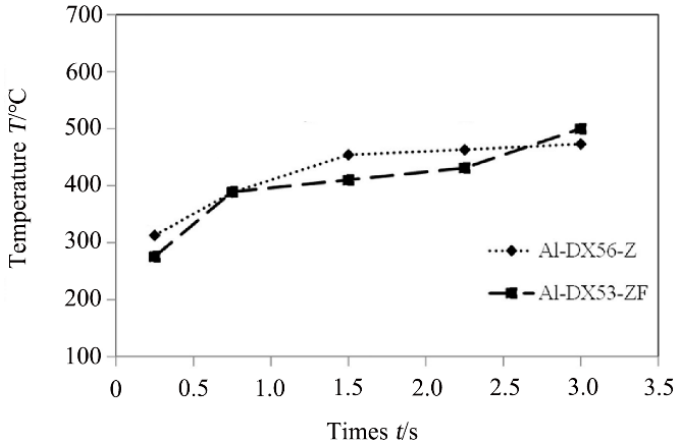
Figure 9. Interface temperatures in 6111 aluminum alloy-to-DX56-Z and 6111 aluminum alloy-to- DX53-ZF from the weld center under the welding pressure of 1.4 kN [35].